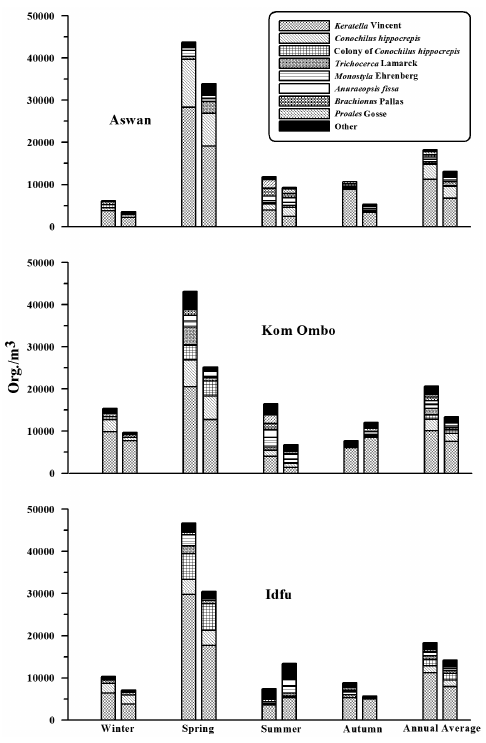
Figure 12. Distribution and seasonal variations of adult copepods in the River Nile. Left bar (upstream) and right bar